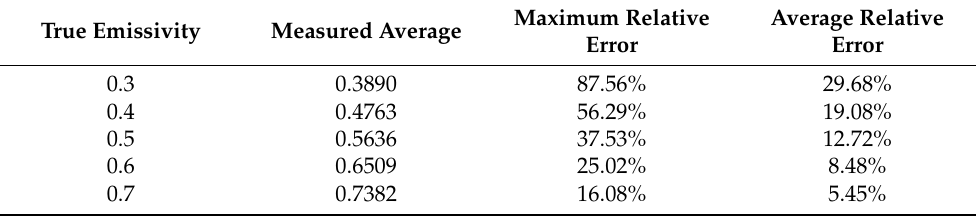
Table 2. Average value and maximum and average relative errors of emissivity measurements.